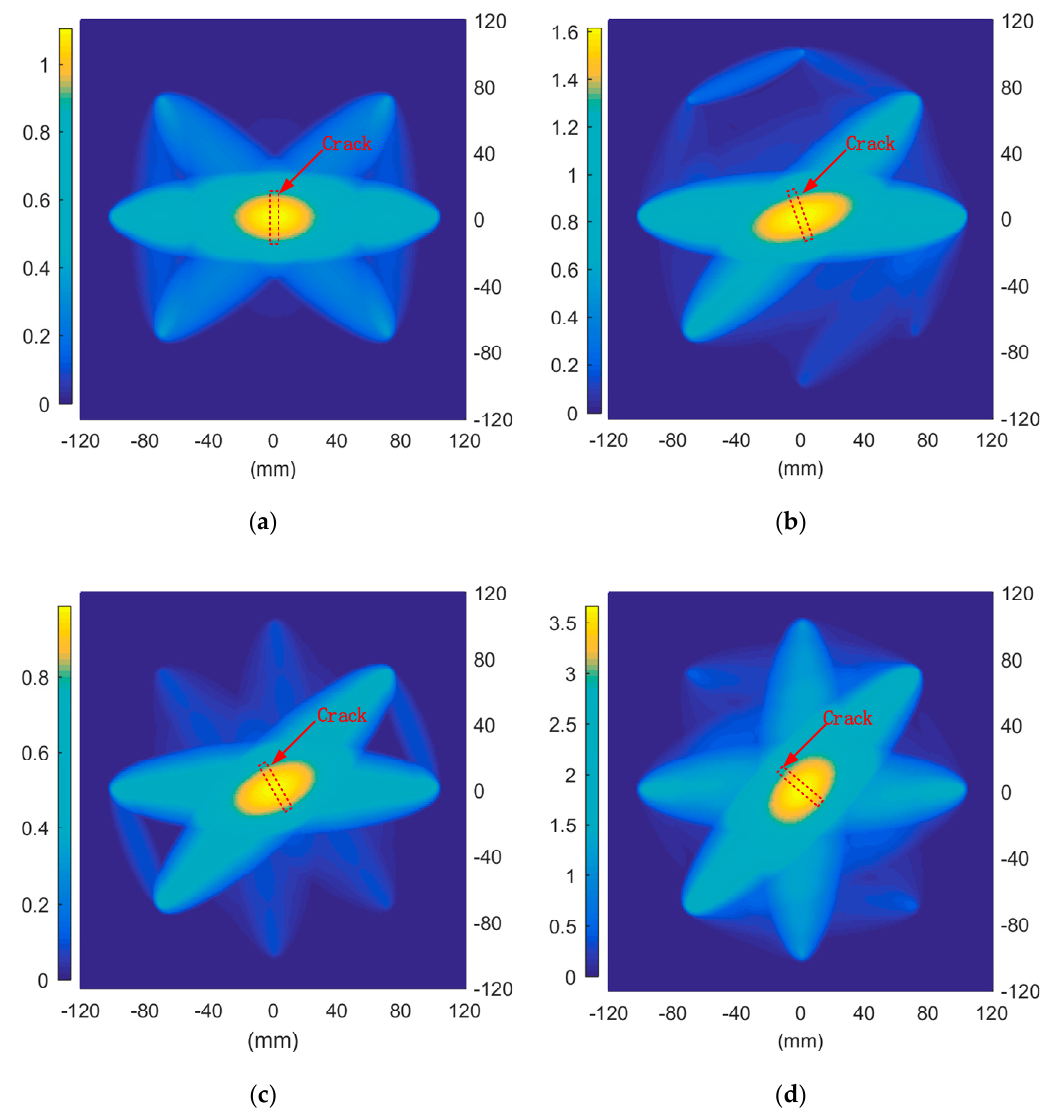
Figure 8. XY view with crack length of 40mm at different angles: ( a ) 0°; ( b ) 11.25°; ( c ) 22.5°; ( d ) 30°.